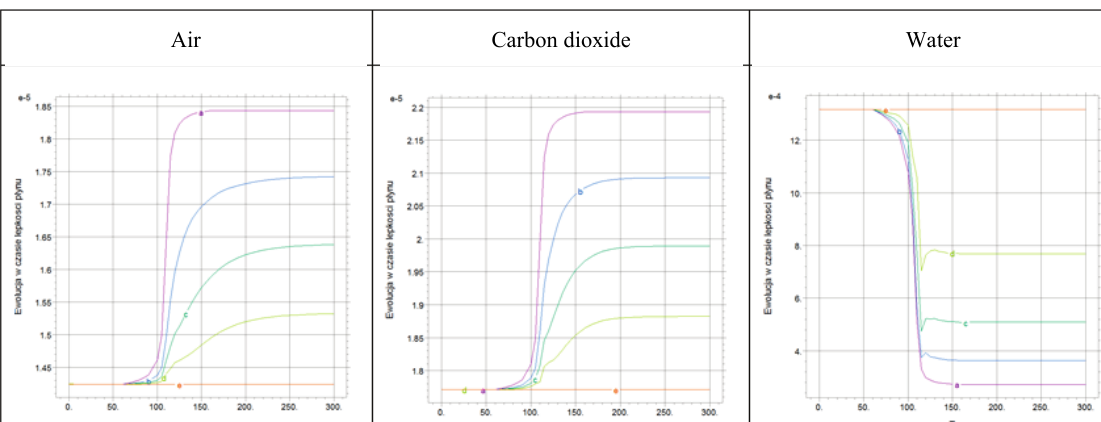
Table 5. Time course of fluid